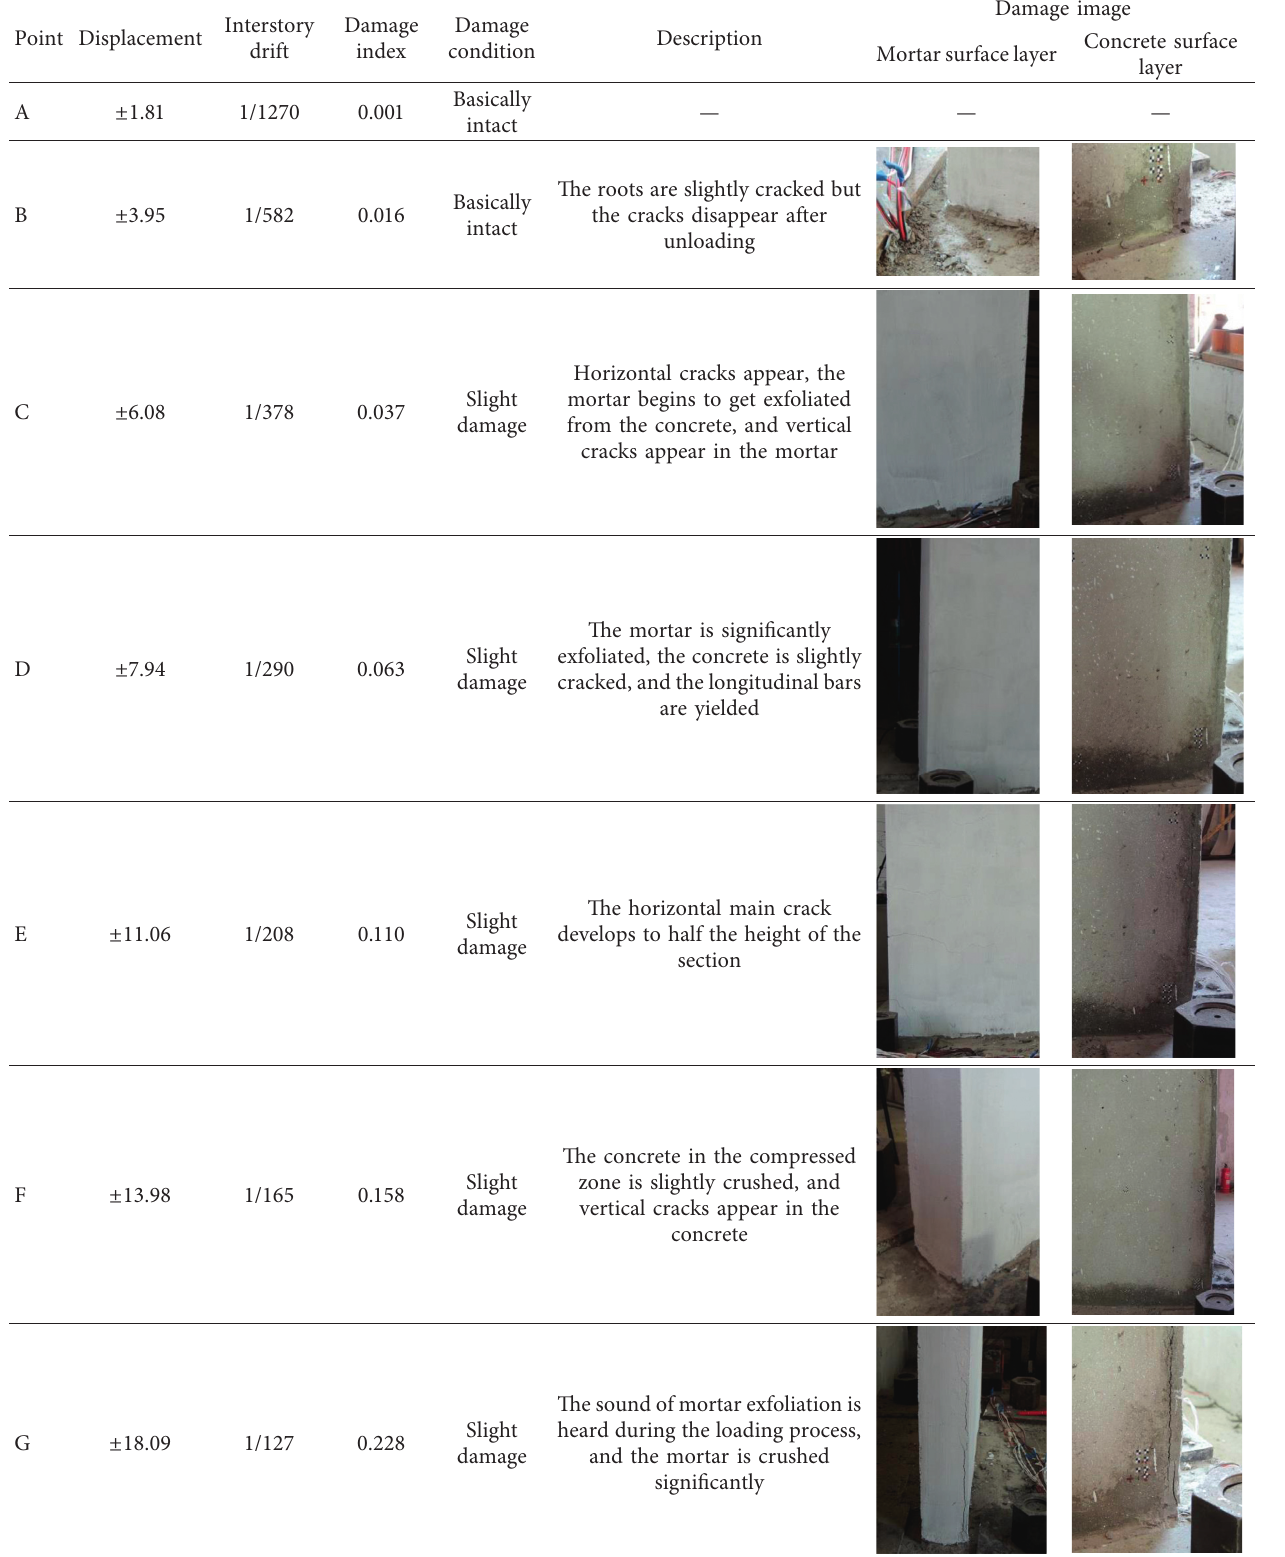
Table 5: Correspondence between the damages and damage indexes of